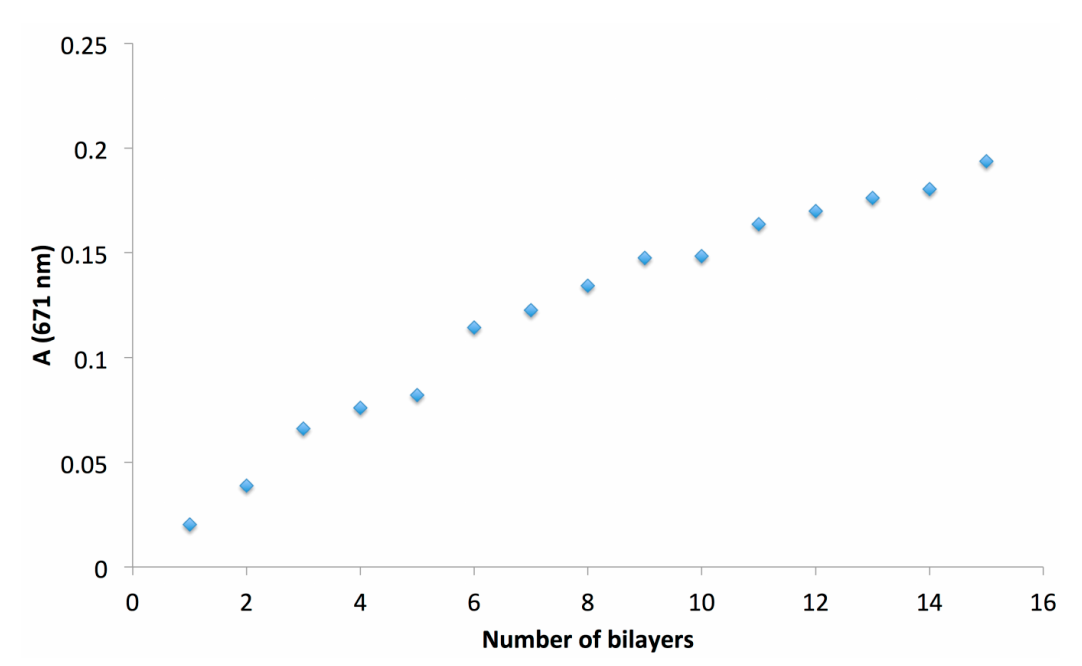
Figure 5. Absorbance measured at 671 nm against the number of PDDA/s-CoPc